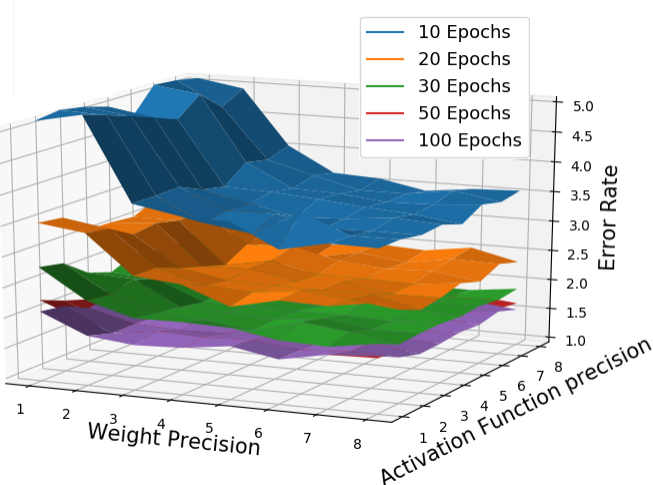
Figure 5. Accuracy of Quantised Neural Networks (QNN) with increasing training Absolute Resource Utilisation Performance